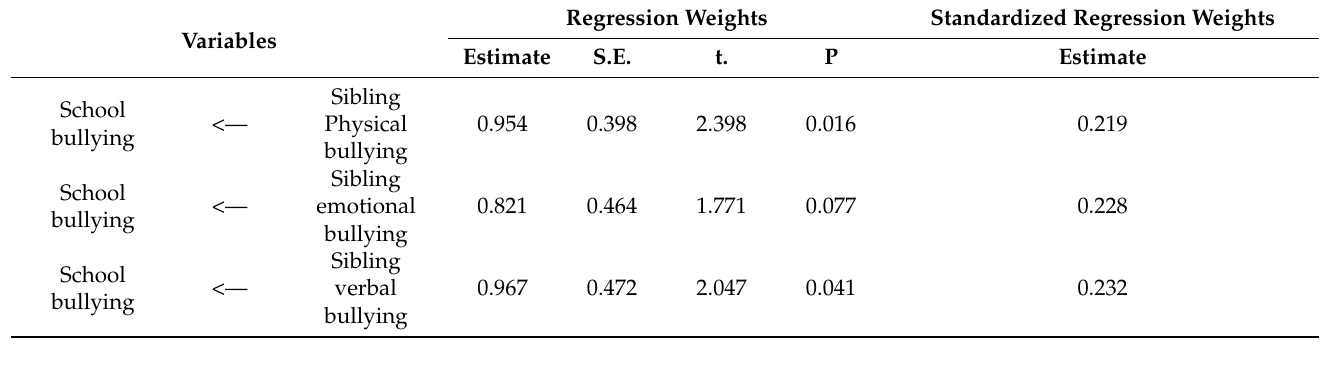
Table 3. Estimates of the effect of the physical, emotional, and verbal bullying by brothers (the bullying) on school bullying.